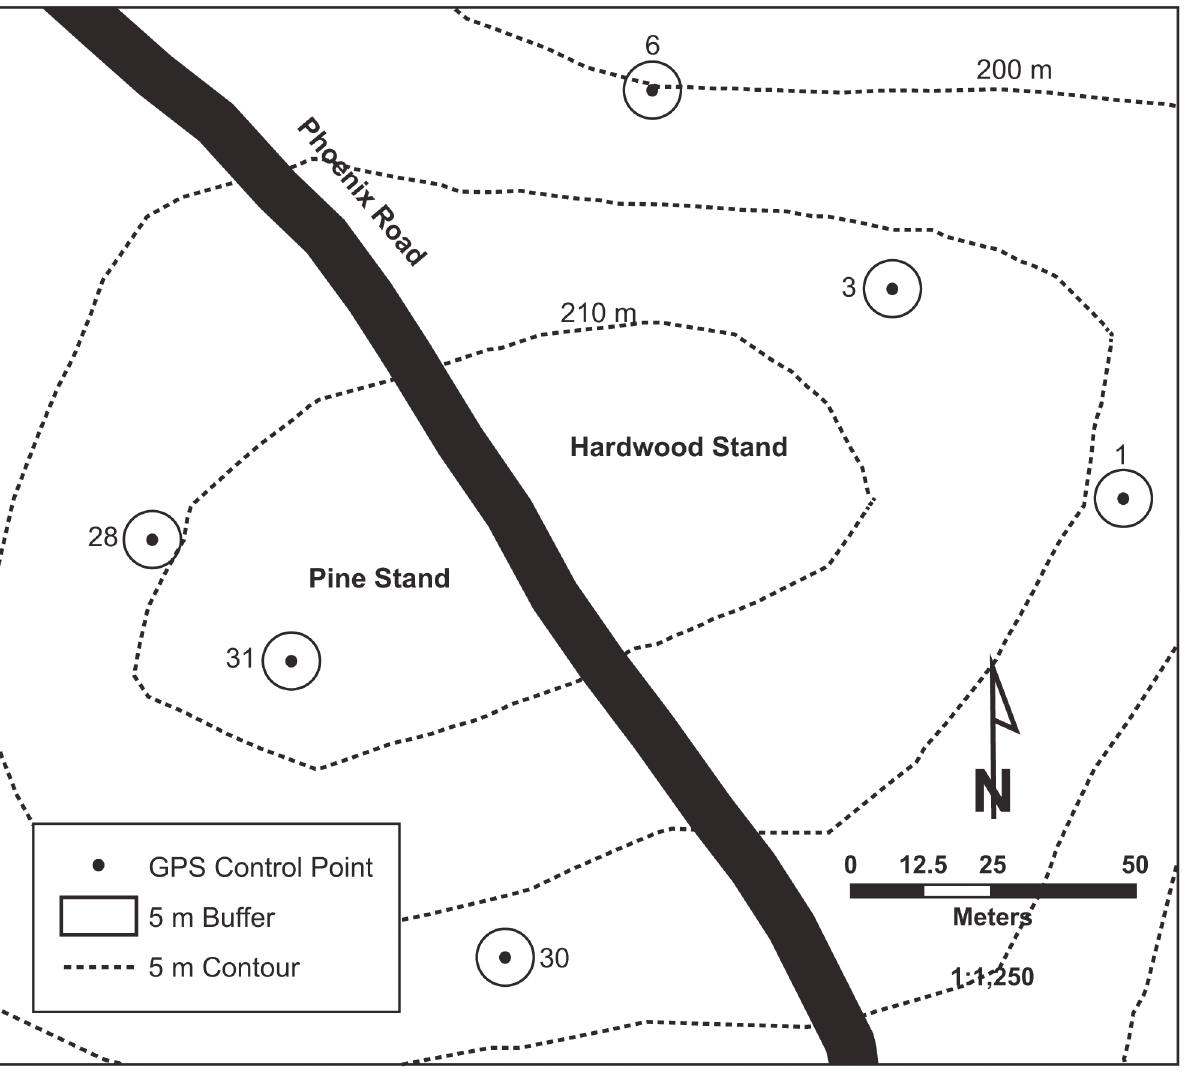
Fig 2. The surveyed control points, with a 5 m buffer shown, located at the Whitehall Forest GPS test site in Athens, Georgia,